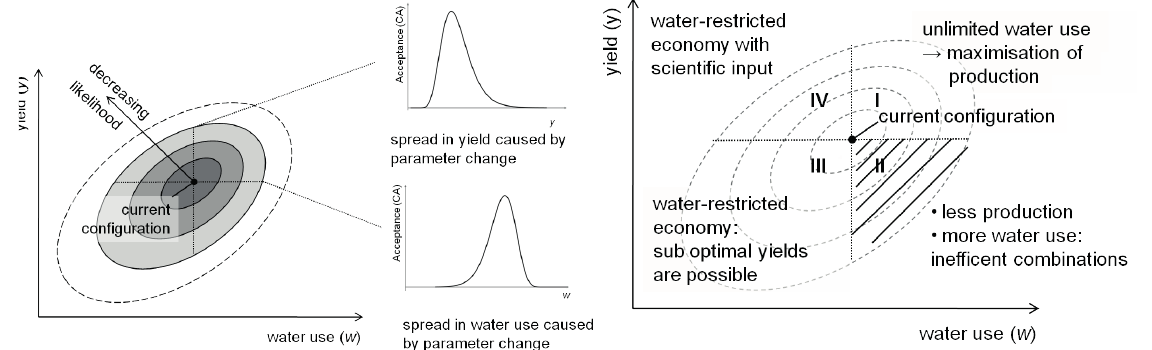
Fig. 3 Strategies to change the agricultural water consumption under consideration of socio-economic effects (Nijssen